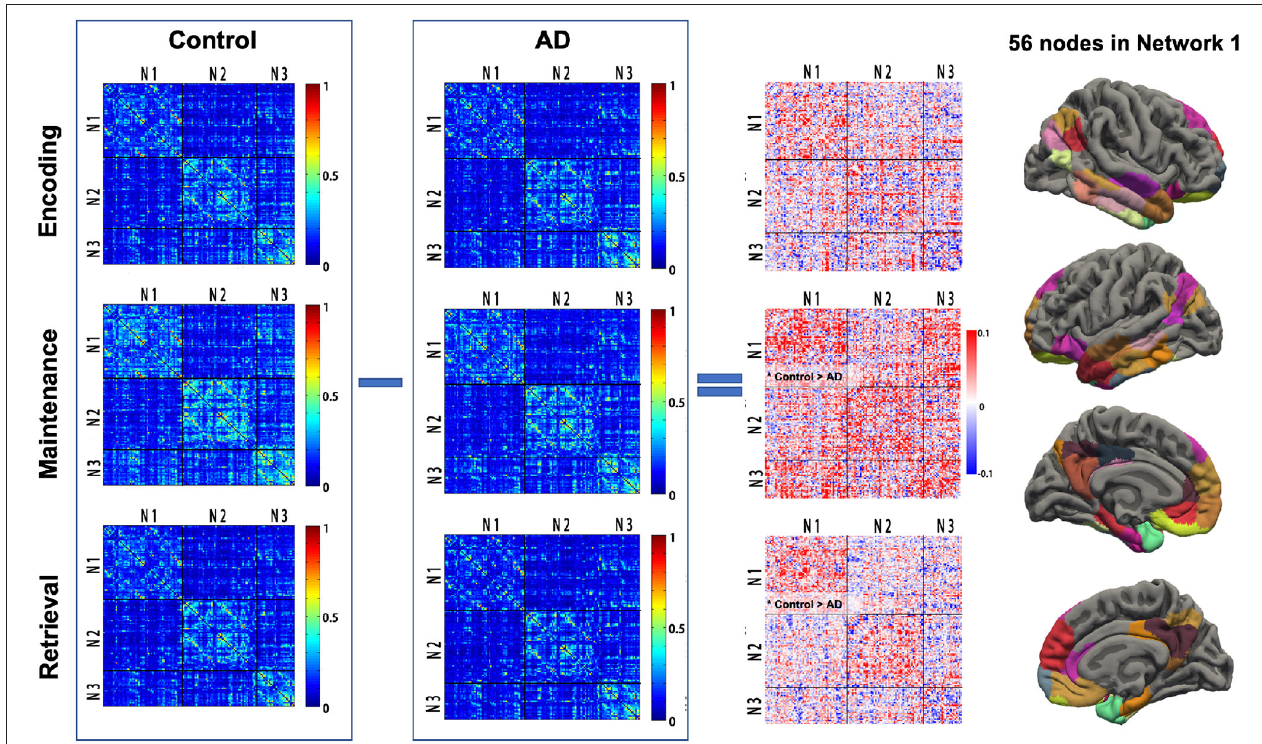
FIGURE 3 | Task phase-related functional connectivity in AD and controls. The first and second columns: averaged functional connectivity (FC) matrices in each task phase of controls and AD. Each cell of the matrix represents the FC strength (Fisher z -transformed r -value) between the cortical nodes. The third column: The difference of FC (control—AD) in each task phase between AD and controls. Black lines indicate the boundary separating nodes allocated to the empirical Networks 1–3. The fourth column illustrated the 56 cortex nodes in Network 1. *Control > AD, significantly reduced mean FC in the Network 1-Network 1 matrix in AD;